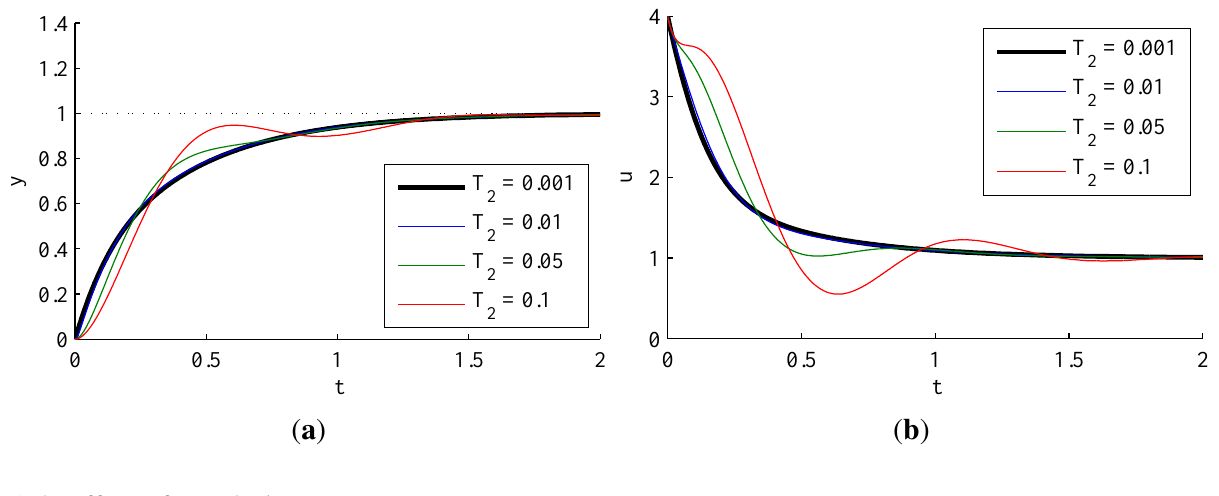
Figure 8. controlling a process with dominating first-order behavior ( K = 1, T = 1) and higher-order dynamics caused by an unknown second pole at s = = 1, s ESO = 2 T s CL . ( a ) Variation of T settle ·